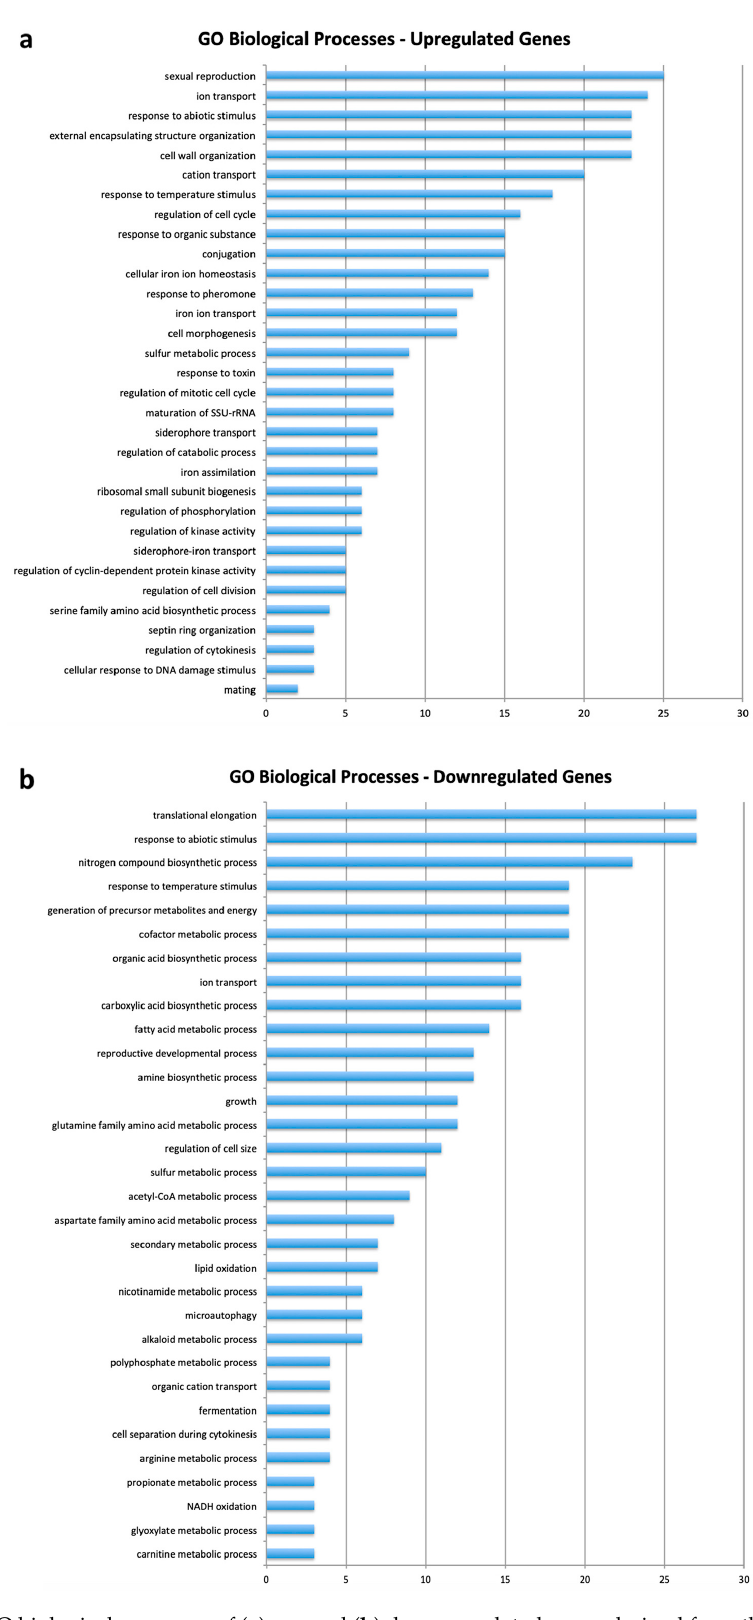
Figure 3. GO biological processes of ( a ) up- and ( b ) down-regulated genes derived from the microarray analysis (fixed thresholds of +1; − 1).